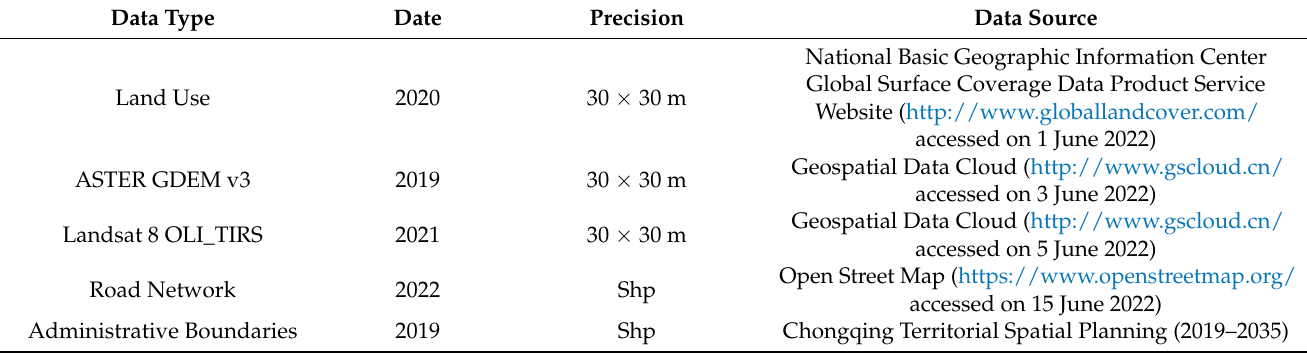
Table 1. Data Table 1. Data source.